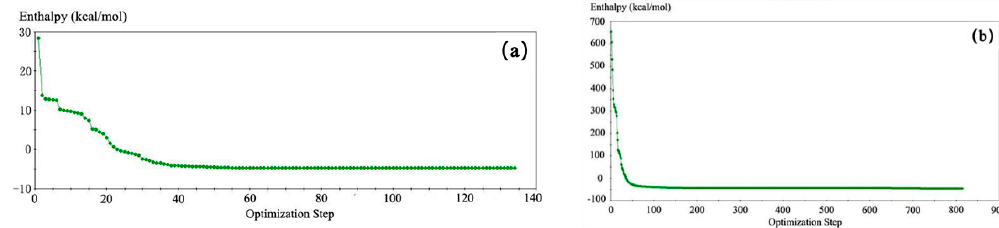
Figure 3. Change of entropy of adsorption process: ( a ) the change of the entropy value in the fixed surface atomic operation; ( b ) the entropy change in the operation when the surface atoms are not constrained.